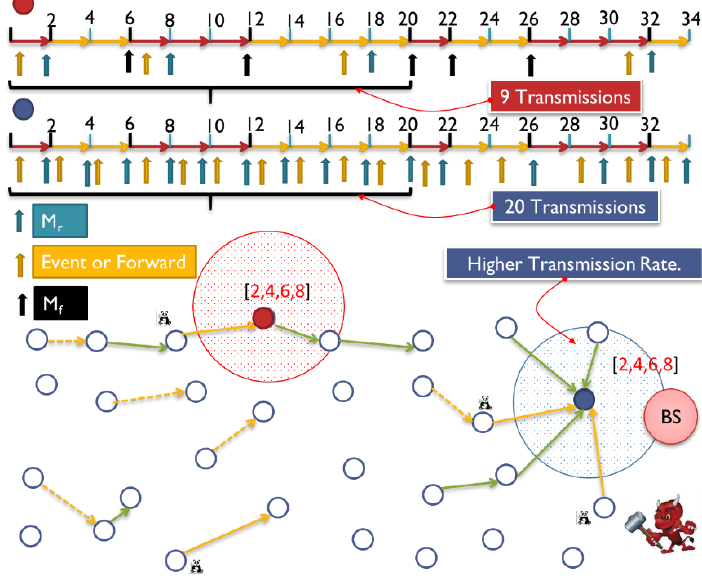
Figure 17. Higher transmission rate next to the BS. The figure exhibits about 20 transmissions